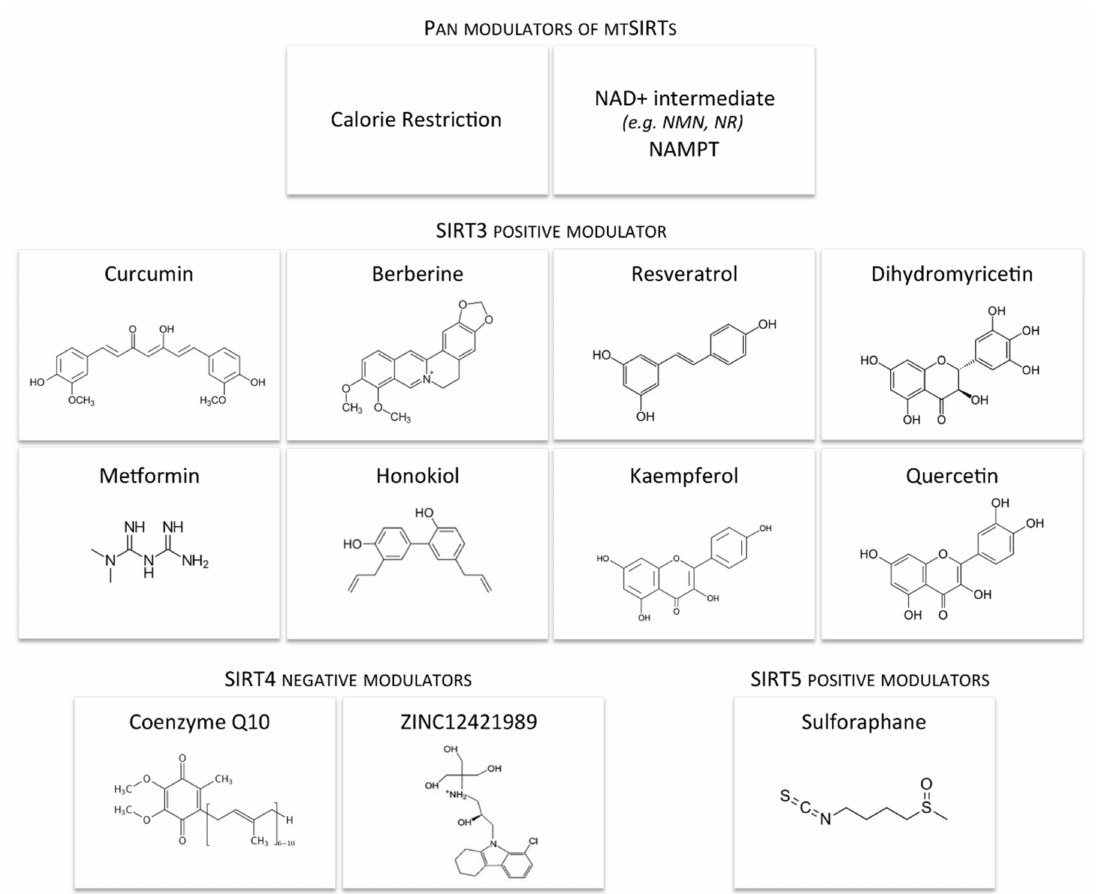
Figure 7. Dietary and pharmacological interventions alleviating manifestations of many diseases by modulating